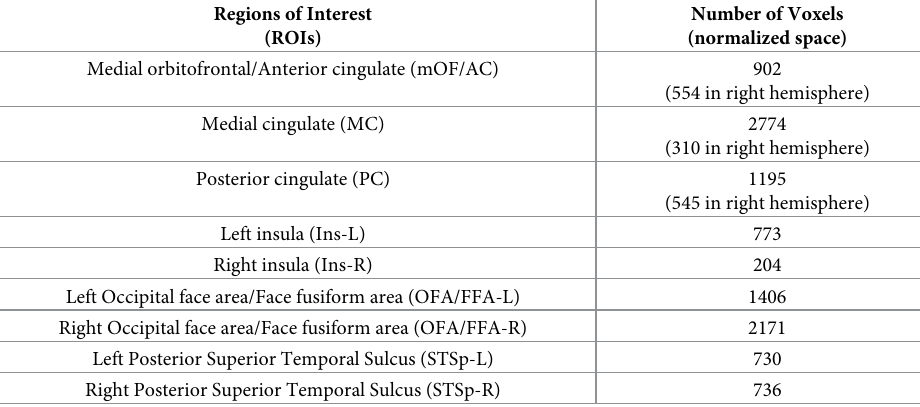
Table 1. Description of the region of interest (ROI) size obtained from activation